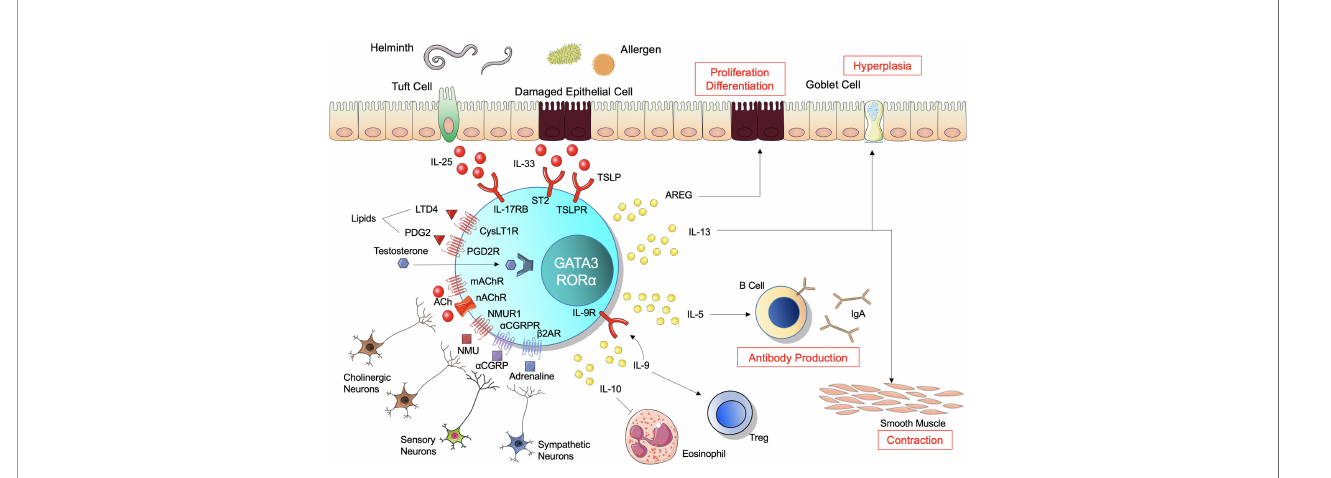
FIGURE 1 | Regulation and function of ILC2. Alarmins, IL-25, IL-33, and thymic stromal lymphopoietin (TSLP), activate innate lymphoid cells 2 (ILC2) to expand and produce cytokines. Neural systems regulate ILC2s bidirectionally through neuropeptides and neurotransmitters. ILC2s require transcription factors GATA3 and ROR a , and subsequently produce various cytokines. IL-13 induces hyperplasia of goblet cells and contraction of smooth muscle in the intestine, involved in clearance of antigens in the lumen. IL-5 regulates B-cell antibody production and enhances IgA production. Amphiregulin (AREG) promotes epithelial cell proliferation and differentiation. IL-9 and IL-10 contribute to resolution of in fl ammation, while IL-9 also promotes regulatory T-cell activation and IL-10 decreases eosinophil recruitment. ILC2 expresses IL-9 receptor and thus receives IL-9 autocrine feedback. Regarding ligands and receptors, red indicates activation, blue indicates inhibition, and purple indicates both